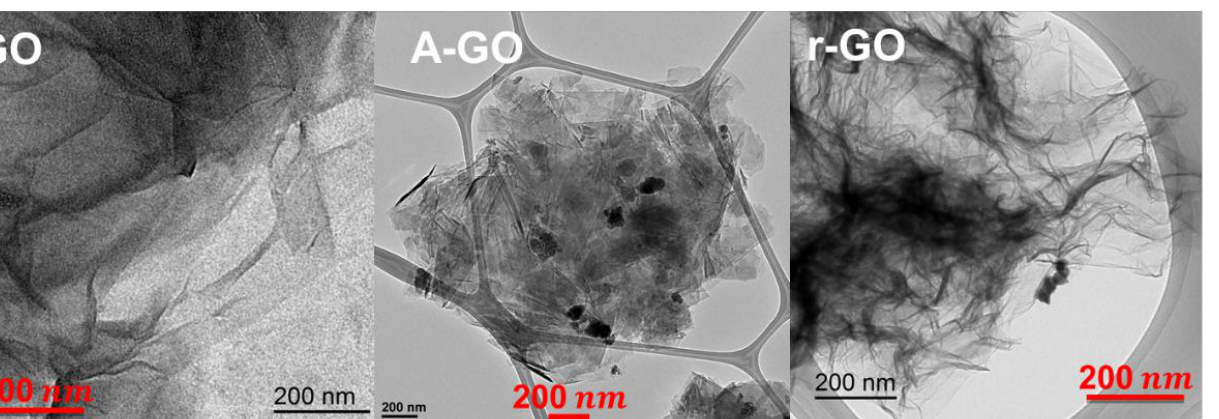
Figure 6. Raman spectra of the graphene oxide derivatives. The increase in the ordered structure of the graphene nano-sheets in A-GO and r-GO is also evidenced in the TEM micrographs (Figure 7). GO shows some individual graphene nano-sheets, but the most common are 4–10 stacked nano-sheets of less than 20 nm thick and 2–5 µ m long. A-GO shows organized and highly stacked graphene nano-sheets whereas r-GO depicts large ultrathin and transparent silk curtain wave-like structure with a large number of wrinkles. Therefore, r-GO and, mainly, A-GO show larger number of stacked graphene nano-sheets than GO. This anticipates more net interactions between the polymers and GO than with r-GO and, particularly, A-GO.